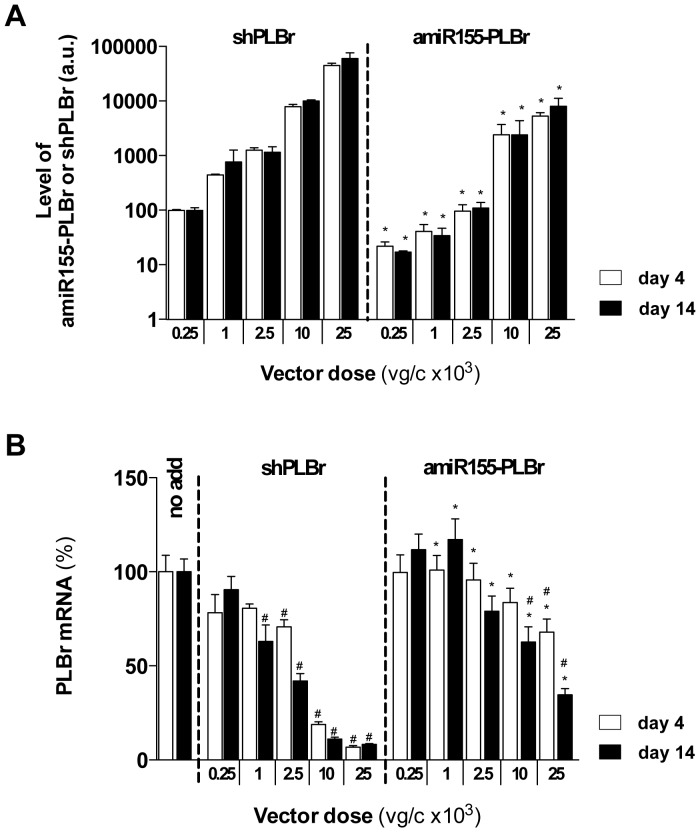
Vector dose dependence of amiR-155-PLBr, shPLBr and PLB mRNA expression in cardiomyocytes (CM) at post transduction days 4 and 14.CM were transduced with indicated doses of scAAV6-shPLBr and scAAV6-amiR155-PLBr and analyzed for expression of processed shPLBr and amiR155-PLBr normalized to 18 S rRNA (A) as well as PLB mRNA normalized to GAPDH mRNA using qRT-PCR (B). All values in A and B were normalized to that obtained for the cells transduced with the lowest scAAV6-shPLBr vector dose. The column labeled no add contains nontransduced cells. *p<0.05 vs. cells transduced with the same dose of the scAAV6-shPLBr vector. #p<0.05 vs. non-transduced cells. a.u., arbitrary units.